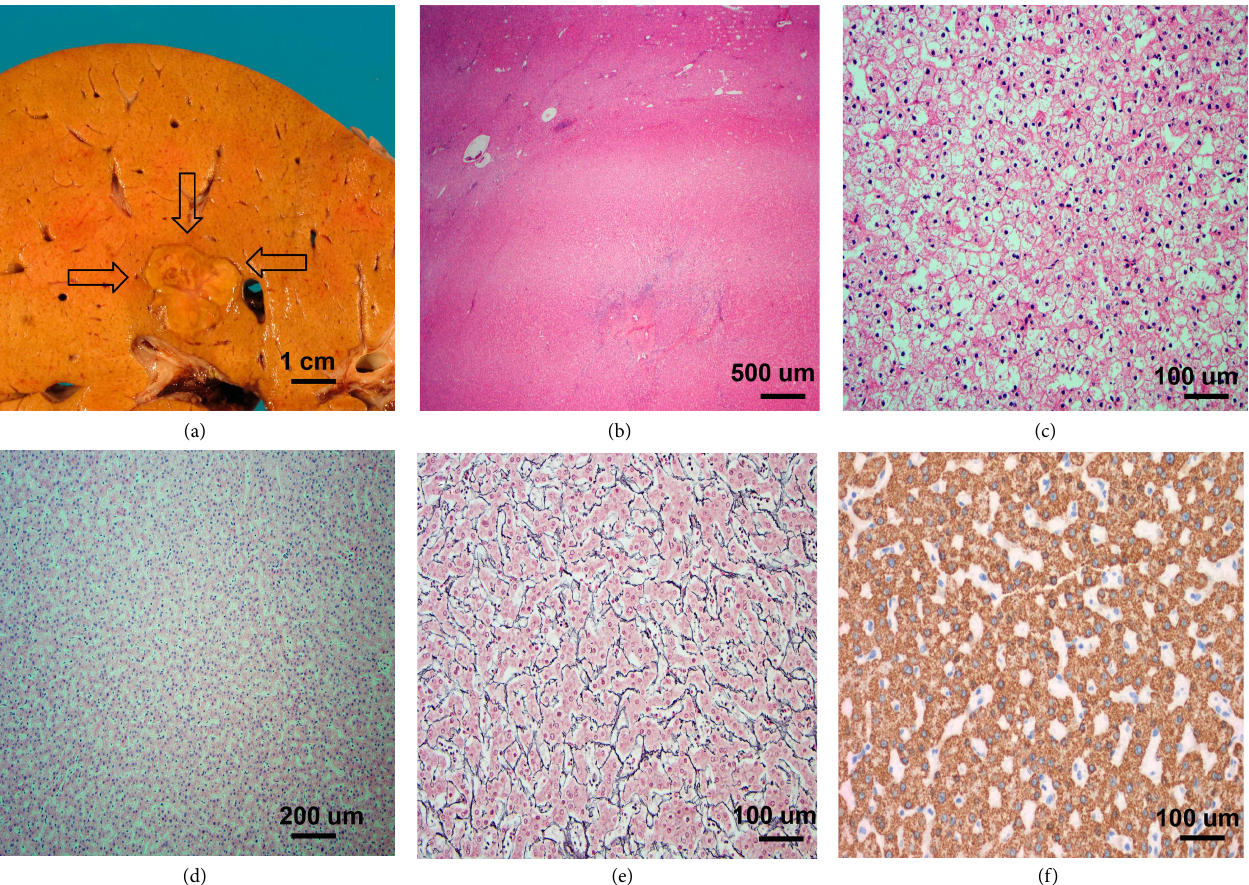
Figure 1: The explant liver from our patient with OTC deficiency contains a hepatocellular adenoma. (a) The tumor is a well-circumscribed, soft, tan nodule (shown by arrows), measuring 2.0 cm. (b) At low power magnification, the nodule is homogeneous without thick fibrous bands (H&E, 40x). (c) The background liver shows glycogen changes with clear to pink cytoplasm and distinct cell membrane (H&E, 200x). (d) The nodule is composed of hepatocytes with normal N/C ratios (H&E, 100X). (e) Reticulin stain highlights the normal reticulin framework and shows the hepatocellular plates of overall 1–2 cells in thickness (200x). (f) Immunostaining for HepPar1 shows diffuse immunoreactivity